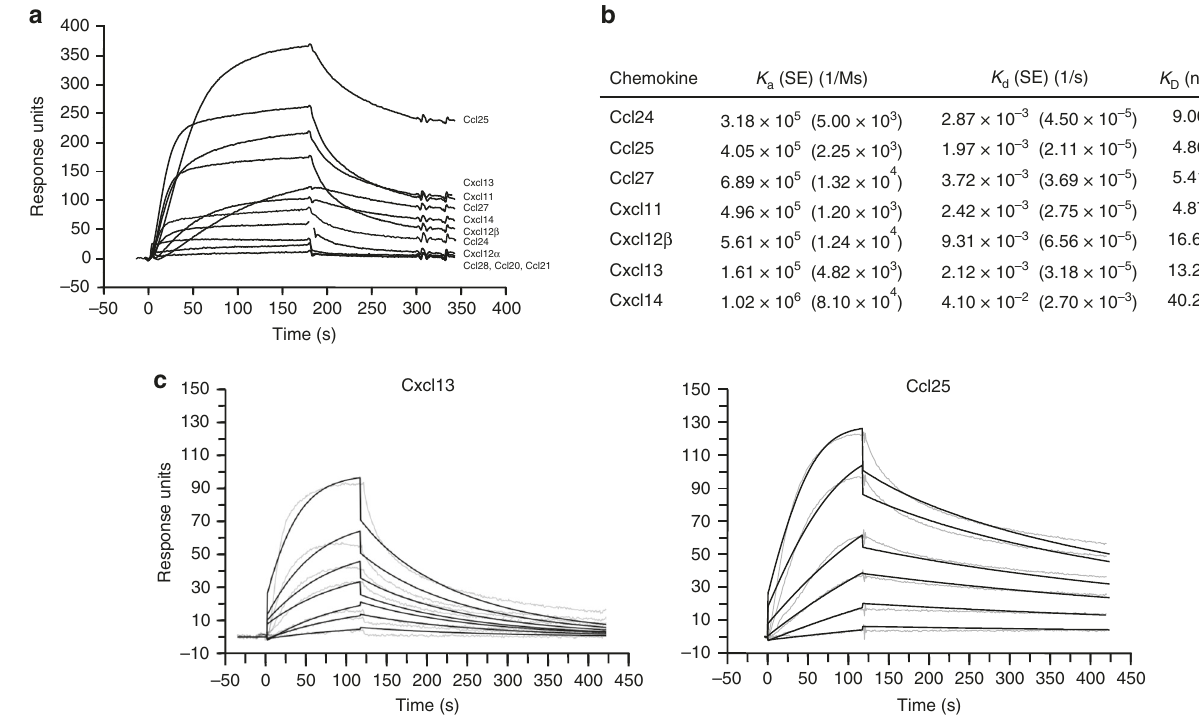
Fig. 4 CrmD binding af fi nity for mouse chemokines. a Binding screening of mouse chemokines to CrmD. Recombinant CrmD was immobilized on a CM4 SPR biosensor chip at 1500 RU. Chemokines (100 nM) were injected at 10 µ l/min fl ow rate in HBS-EP buffer. Binding was monitored during 180 s followed by a 120 s dissociation periods. b Binding kinetic constants K a (association), K d (dissociation) and K D (af fi nity) and their corresponding SEM for the CrmD interaction with some of its chemokine ligands. For af fi nity determination purposes, CrmD was immobilized on a CM4 SPR biosensor chip at 900 RUs. The binding of increasing concentrations of chemokine (1 – 50 nM), injected at a 30 µ l/min fl ow rate, was recorded during 120 s followed by